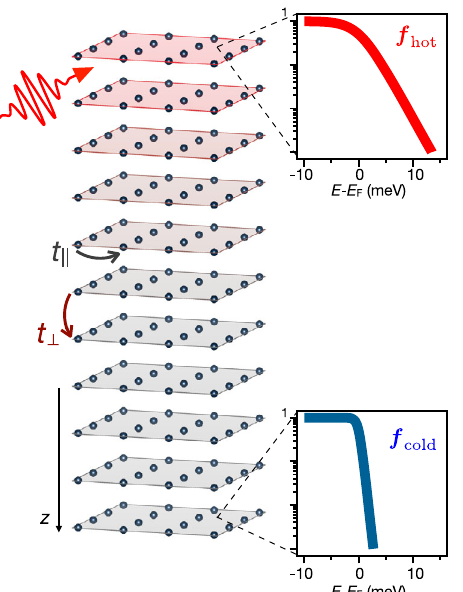
Fig. 1 Setup. Cartoon of the layered correlated material impulsively excited on the top surface by ultrafast light pulses. We assume that the excitation drives a fast thermalization of the electronic population establishing an electronic temperature T hot on the topmost layers of the sample. The right panels display the electronic distributions at different depths after the equilibration step (see